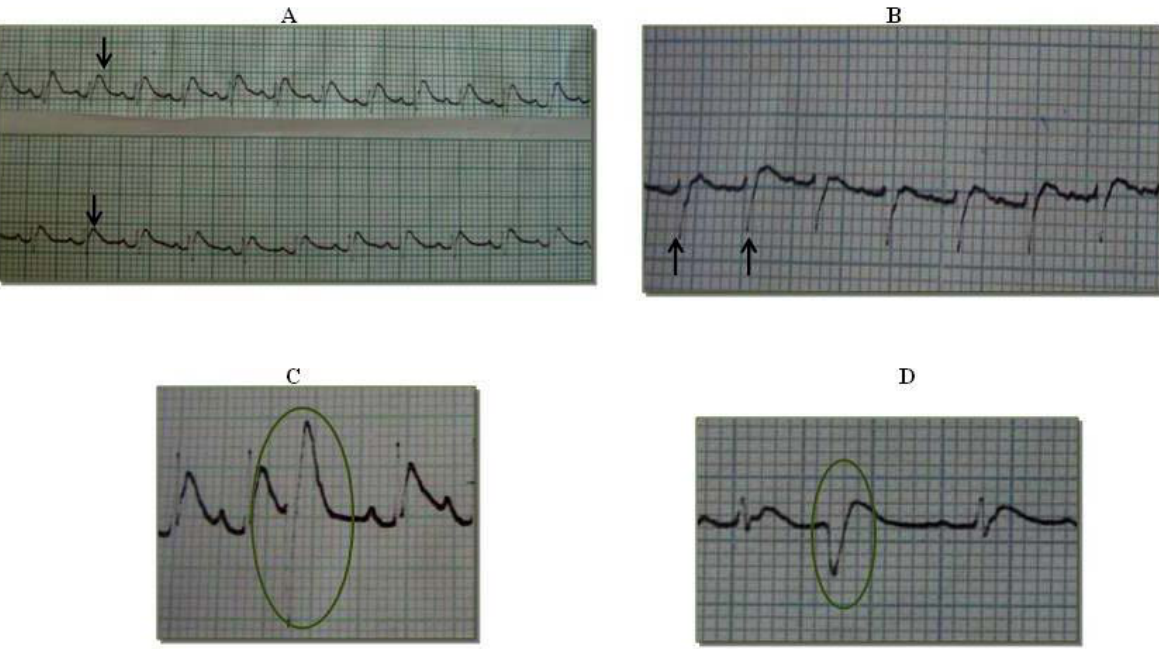
Figure 1. Electrocardiographic traces for animals subjected to experimental envenomation using Tityus serrulatus venom; ( A ) increased T wave at ten minutes for animals in both envenomed groups, ( B ) presence of an rS wave at ten minutes for animals in groups B and C, and ( C-D ) premature ventricular complexes at 15 and 20 minutes for all envenomed animals (PVC; circled). Speed of 50 mm/s and sensitivity of